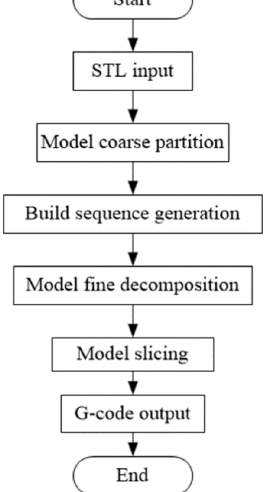
Figure 2. Flow chart of the non-directional unsupported 3D printing method.